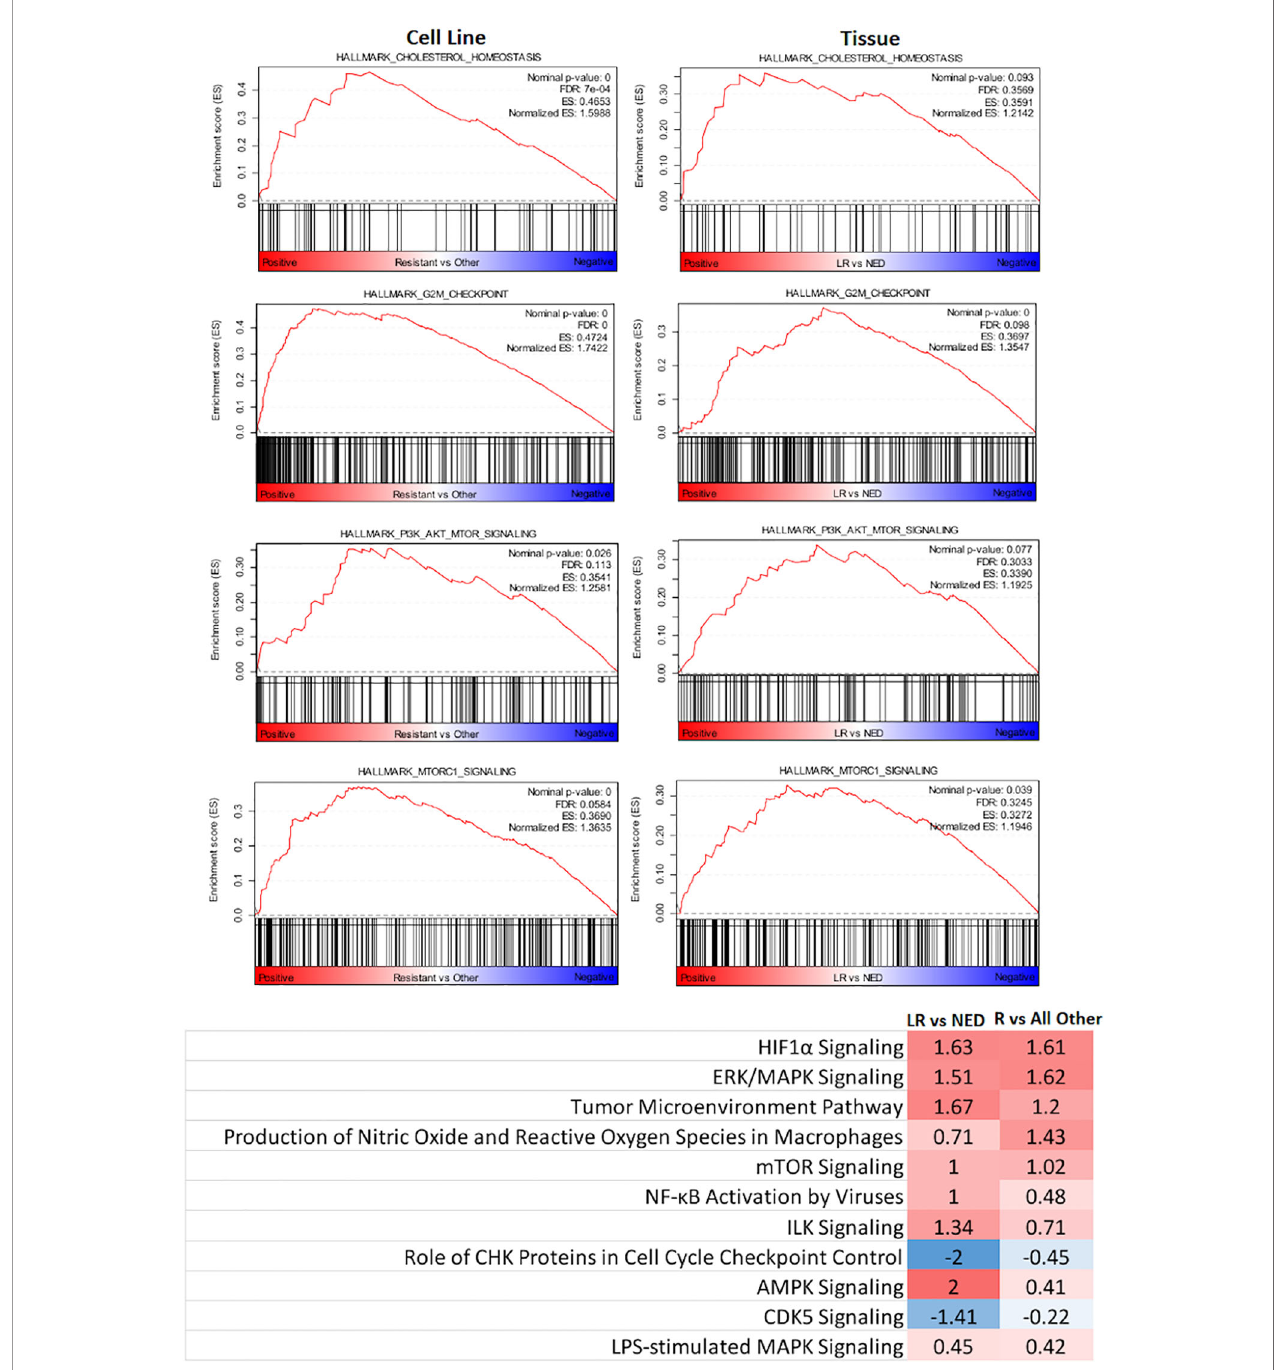
FIGURE 3 | Identi fi cation of key signaling pathways that segregate radioresistant cells from others and comparison with key signaling pathways identi fi ed in HNSCC tumors treated by PORT and classi fi ed by their treatment response: no evidence of disease (NED) and local recurrence